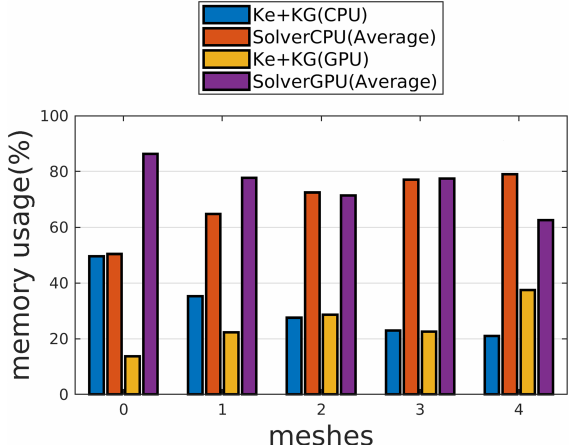
Figure 15. Speedup in relation to solution times using pcg.